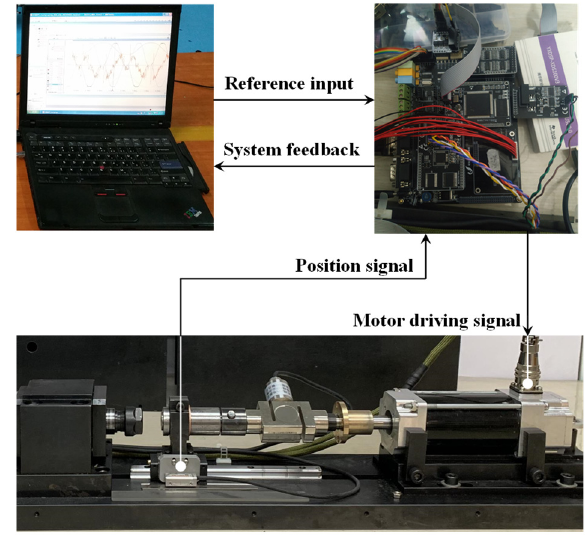
Figure 3. Schematic of Experimental Hardware Architecture.